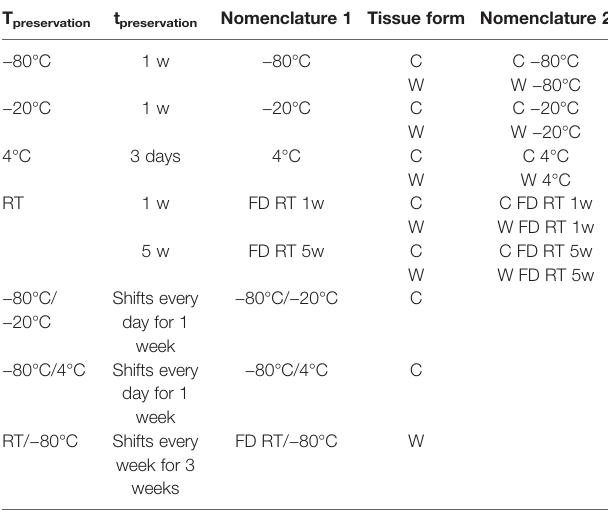
Nomenclature 1 is independent from tissue form. Nomenclature 2 is dependent from tissue